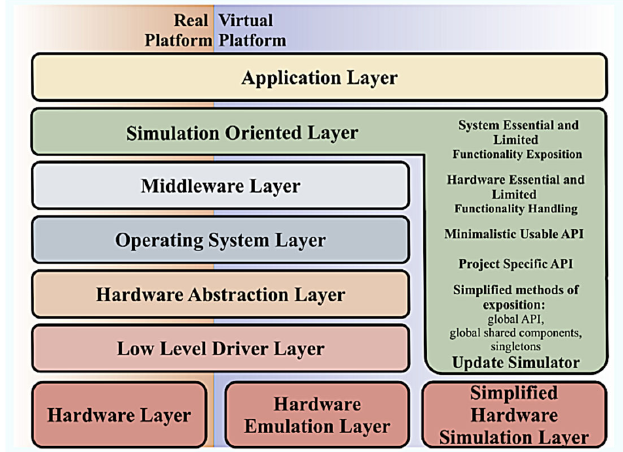
Figure 7. Proposed Simulation ‐ Oriented Layer as a top ‐ level API.